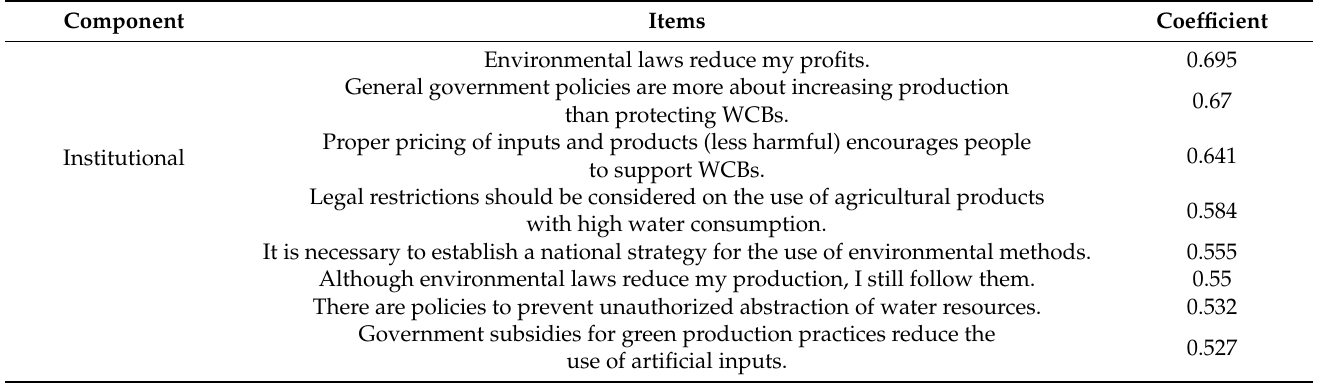
Table 6. Characteristics of factors extracted from the factor